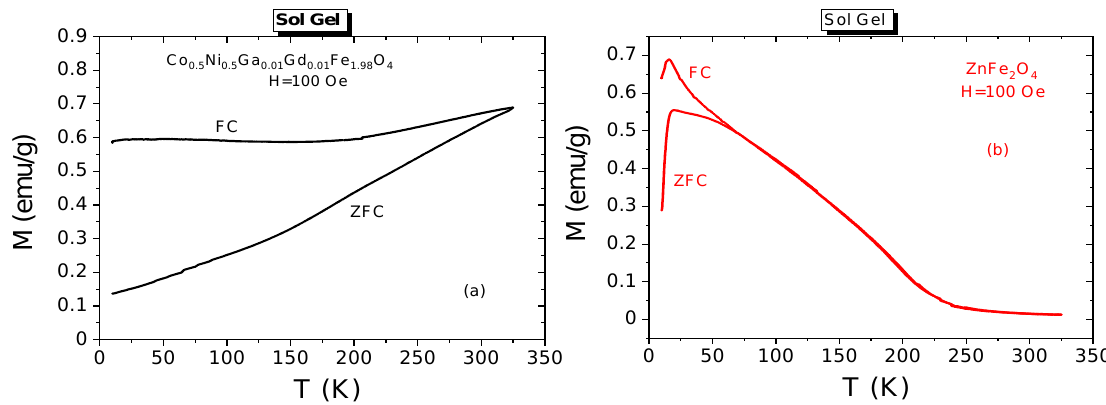
Figure 11. Temperature dependence of ZFC and FC magnetizations for ( a ) Co 0.5 Ni 0.5 Ga 0.01 Gd 0.01 Fe 1.98 O 4 and ( b ) ZnFe 2 O 4 NPs synthesized by sol-gel method.